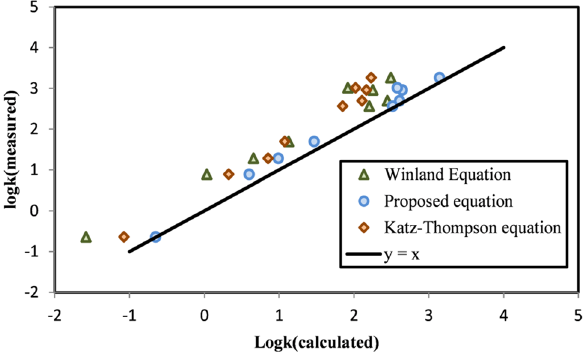
Fig. 11 Cross-plot of measured and calculated permeabilities for pro- posed, Winland, and Katz and Thompson equations (sandstone sam- ples) Table 3 The absolute average relative error (AARE) and the standard deviation (SD) of the relative error of the predicted permeabilities by each correlation for sandstone samples Parameters Proposed